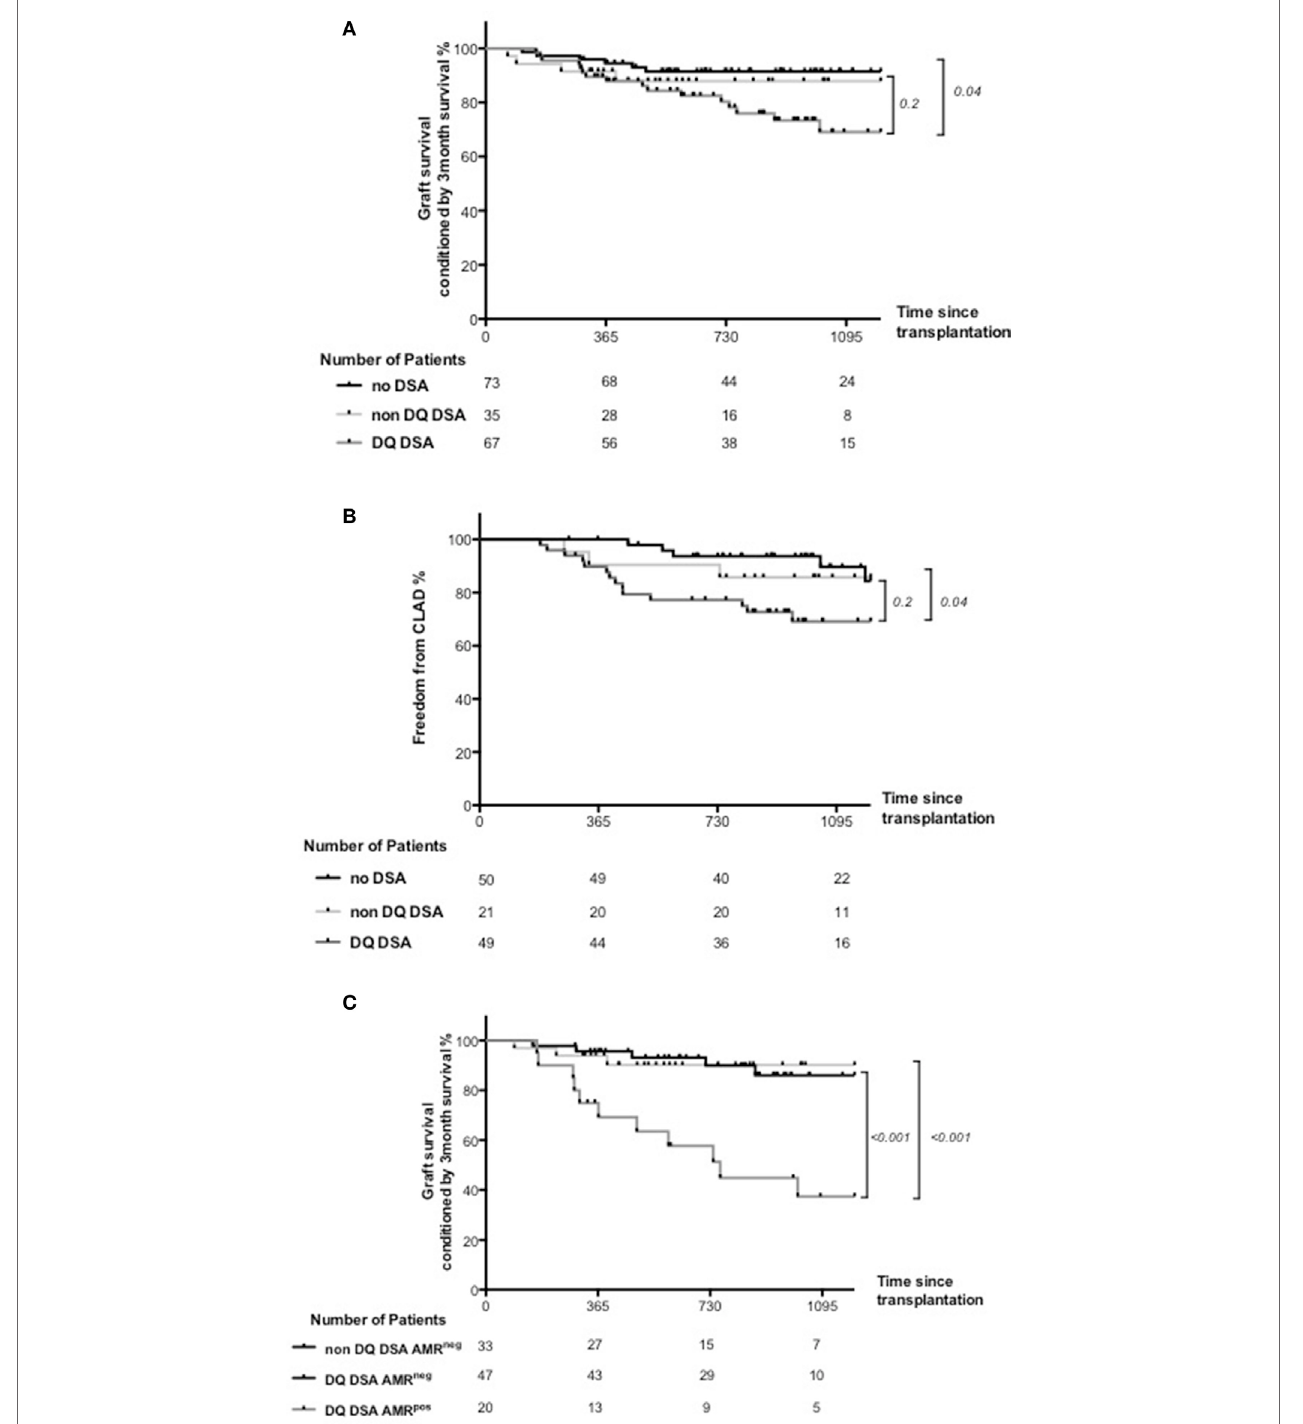
FigUre 5 | Clinical outcome associated with anti-HLA DQ donor-specific antibody (DQ DSA). Patients were categorized as DQ DSA if they had at least once DSA directed against one DQ antigen. Patients were categorized as non DQ DSA if they had DSA but never directed against DQ antigen. (a) Graft survival conditioned by 3-month survival compared between DSA negative, non-DQ DSA and DQ DSA patients. Global comparison was statistically significant, but non-DQ DSA and DQ DSA comparison did not reach significance. (b) CLAD occurrence between DSA negative, non-DQ DSA, and DQ DSA patients. Again, global comparison was statistically significant, but non-DQ DSA and DQ DSA comparison did not reach significance. (c) Graft survival conditioned by 3-month survival compared between non DQ DSA AMR neg , DQ DSA AMR neg , and DQ DSA AMR pos patients. The only non-DQ DSA AMR pos patient was exclude of the analysis. Both global and DQ DSA AMR neg and DQ DSA AMR pos comparison were highly